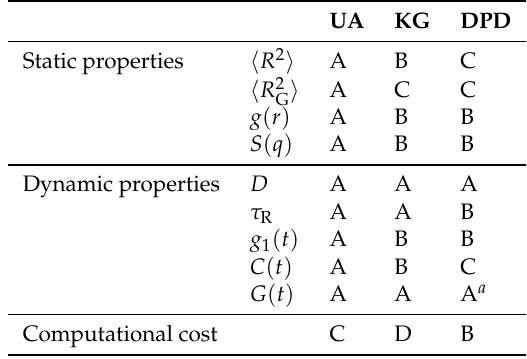
Table 2. Comparison of overall performance of molecular models for PE melts simulations. “A”, “B”, “C”, and “D” mean “very good”, “good”, “adequate”, and “no good” performance, respectively. a “very good” after using Equation